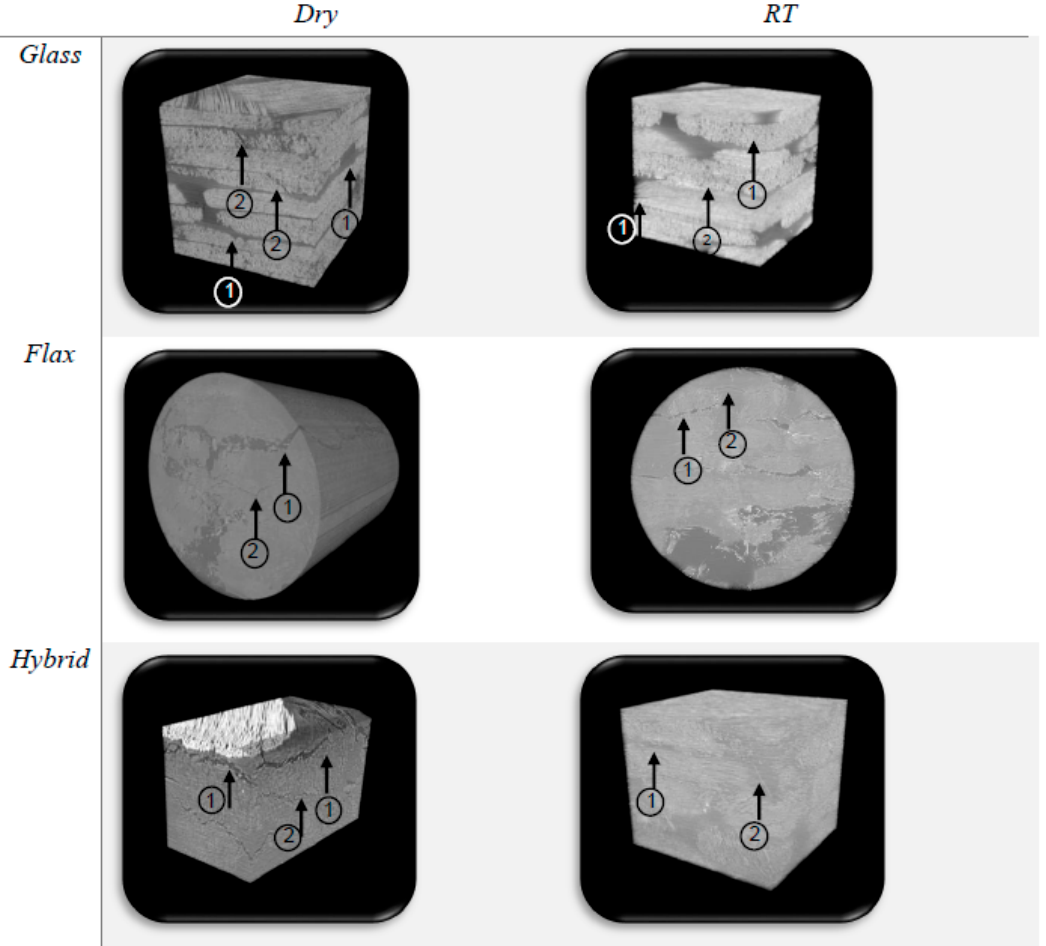
Figure 6. X-ray pictures of dry and RT immersed glass fibre, flax fibre and hybrid composites showing the damage mechanisms: (1) show delamination, (2) matrix cracking.